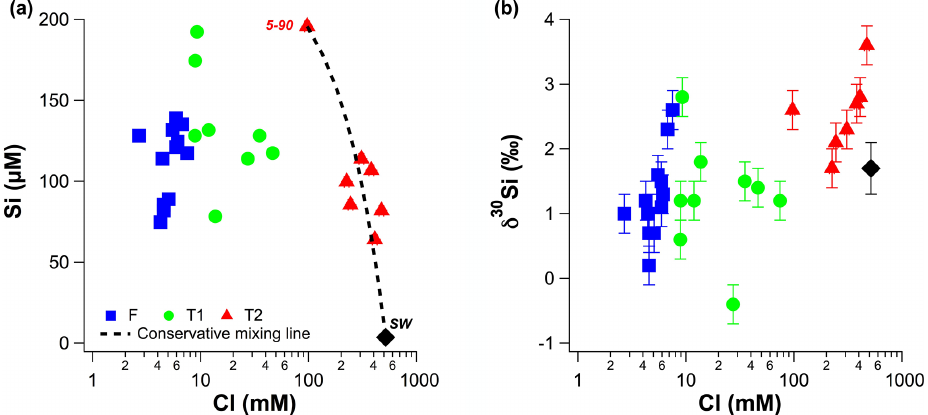
Figure 3. (a) Molar dSi concentrations as a function of molar Cl concentrations. (b) δ 30 Si values as a function of molar Cl concentrations. The dashed line in (a) represents theoretical mixing between local seawater and the T2 groundwater with the highest dSi concentration (well 5–90).